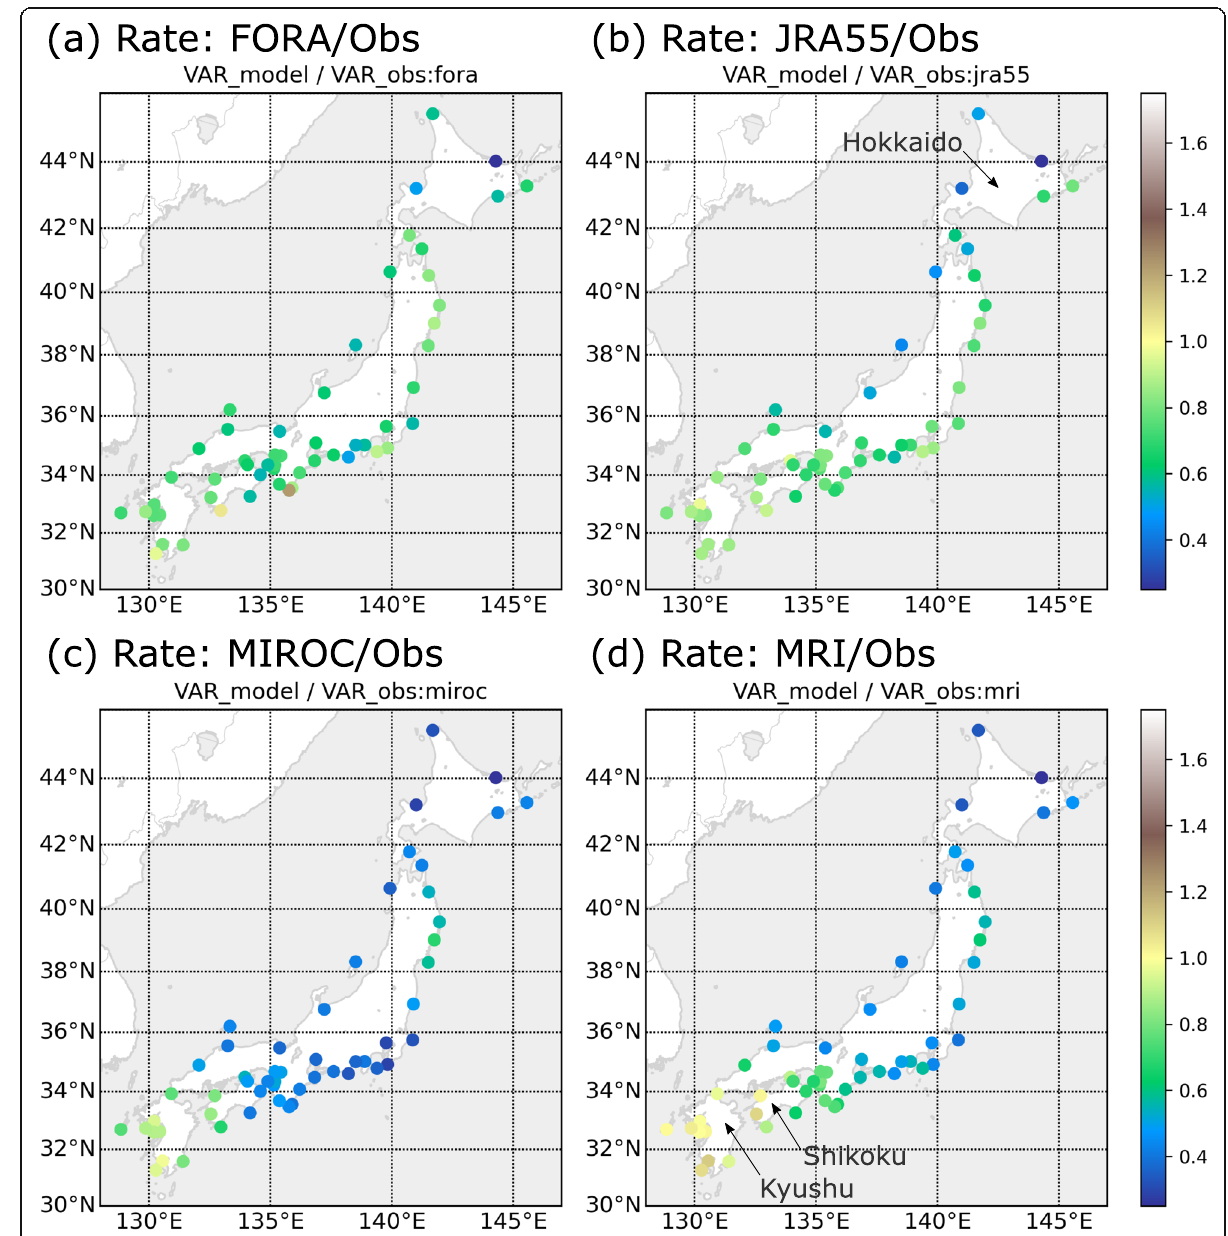
and the JPN02 results of b JRA-55, c MIROC5, and d MRI-CGCM3, which are denoted by colored circles. The calculation of variance was based